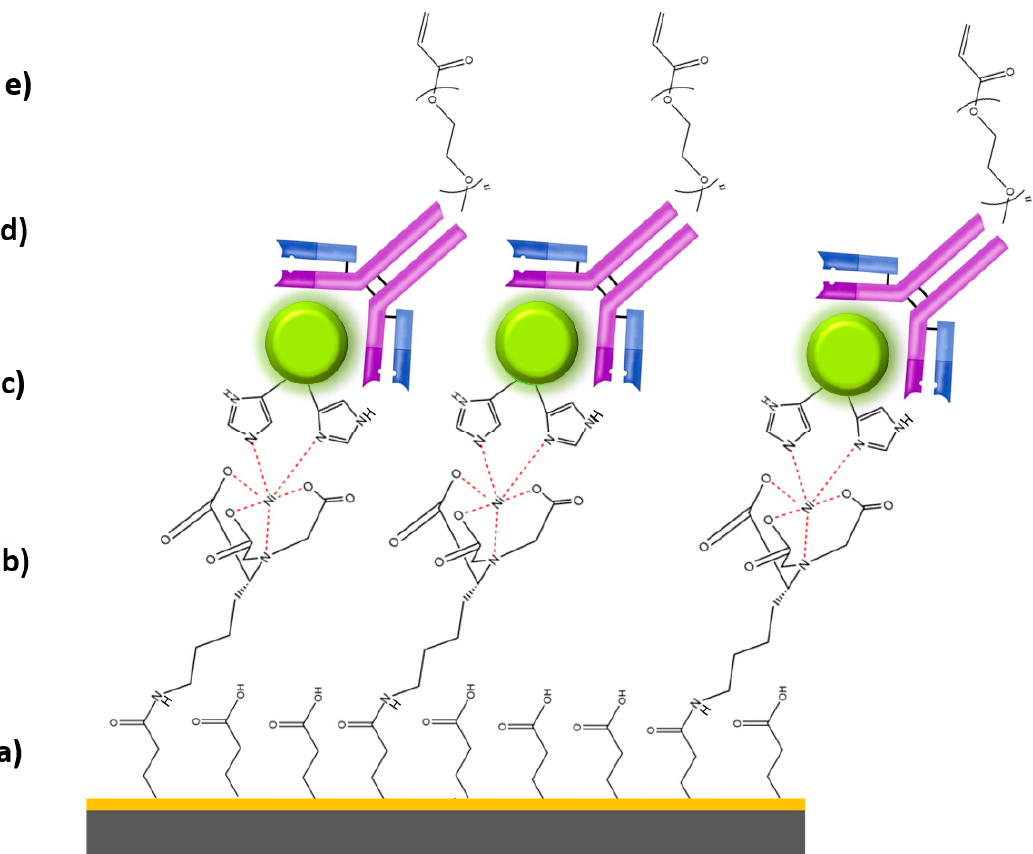
Figure 3. The scheme shows the steps of the site-directed functionalization of the antibody. ( a ) Coating of the gold surface with the organic acid MUA; ( b ) binding of NTA-lysine and complexation with Ni 2+ ; ( c ) functionalization with the His-tagged antigen. ( d ) The immobilized protein was recognized by the target antibody. ( e ) Finally, the constant fraction of the antibody was functionalized with Acryl-PEG-NHS. Appl. Sci. 2020 , 10 , x FOR PEER REVIEW